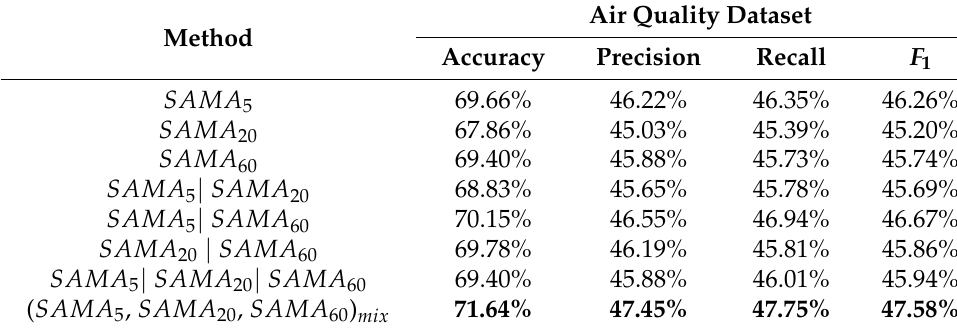
Table 3. Performance of multi-scale SAMA indicator fusion (air quality